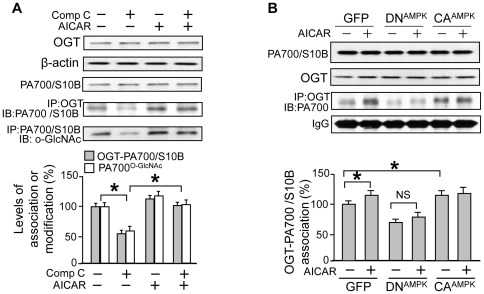
AMPK suppression is accompanied by the decreased association of OGT with proteasome.AMPK suppression in HUVEC either by (A) compound C (10 µmol/L for 2 hour) or by (B) overexpression of AMPK-dominant negative mutant (DN) decreases both the OGT association with proteasome and the O-GlcNAcylation of PA700/S10B (vs. controls), which can be reversed by AICAR pre-incubation (2 mmol/L for 6 hours) in AMPK-present but not AMPK-DN cell. In contrast, constitutive activation of AMPK (overexpression of AMPK-CA vs GFP) (B) increases OGT-PA700 association. All of the blots shown are representative of 3 independent experiments. NS reprents not significant.